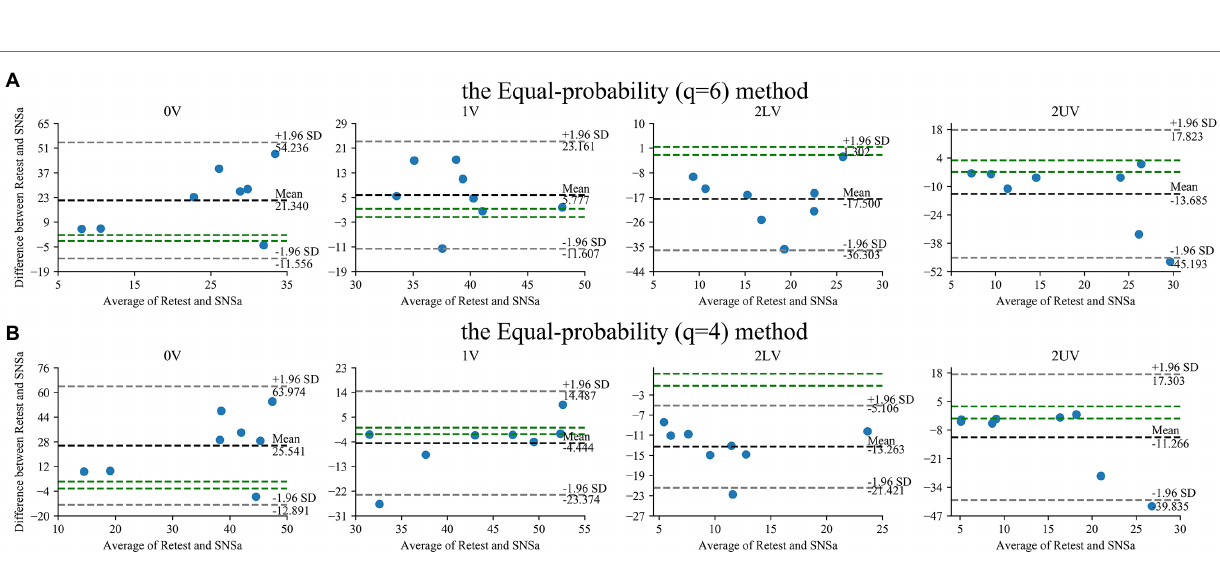
FIGURE 5 | Bland–Altman plots for SymDyn indices 0V, 1V, 2LV, and 2UV (Retest and SNSa stimulation): the Equal-probability method (A) q = 6, (B) q = 4. The black dashed line indicates the mean difference, the grey dashed lines are the limits of agreement (±1.96 SD), and the green lines are the maximum allowed